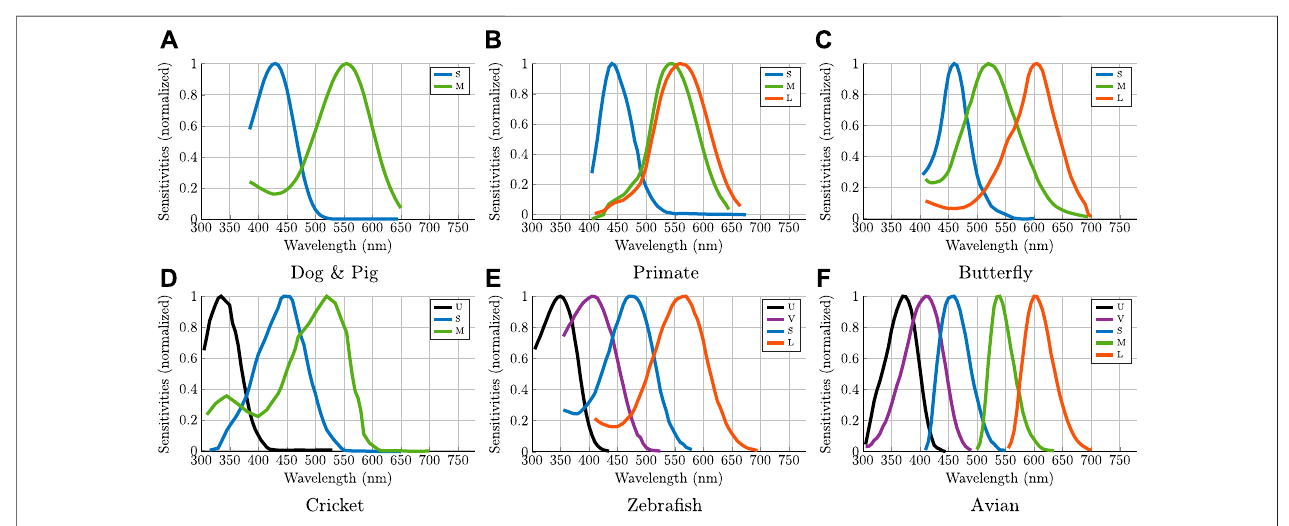
FIGURE 4 | Normalized spectral sensitivities S of each selected animals. U, V, S, M, and L refer to the ultraviolet (UV-A), violet (VS), short-wavelength (SWS), medium-wavelength (MWS), and long-wavelength-sensitive (LWS) cones respectively. The names only indicate the approximate peak wavelength and are different between the